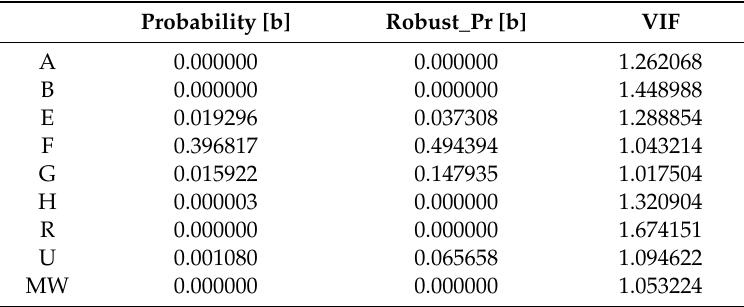
Table 7. The validation set diagnostics.